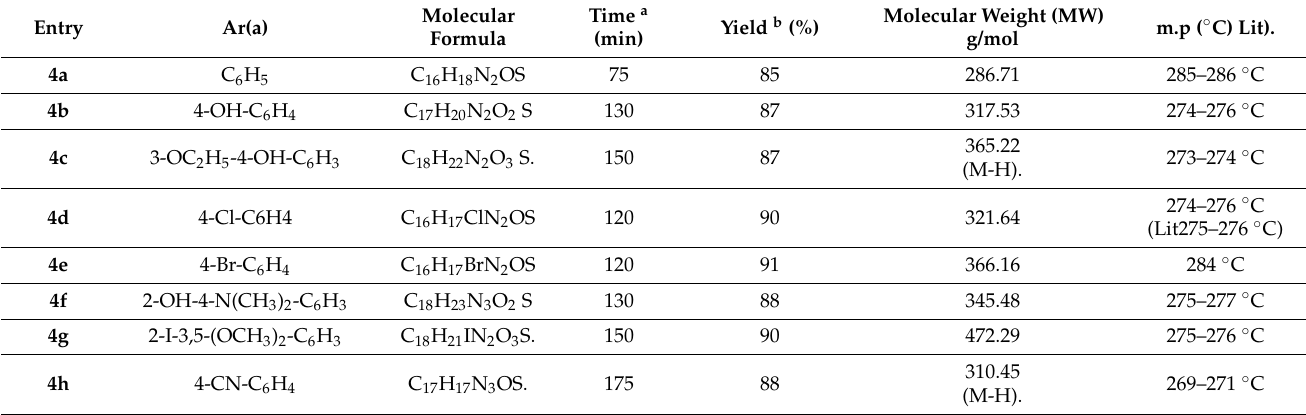
Table 2. Synthesis of titled derivatives catalyzed by nanocatalyst solvent-free condition.